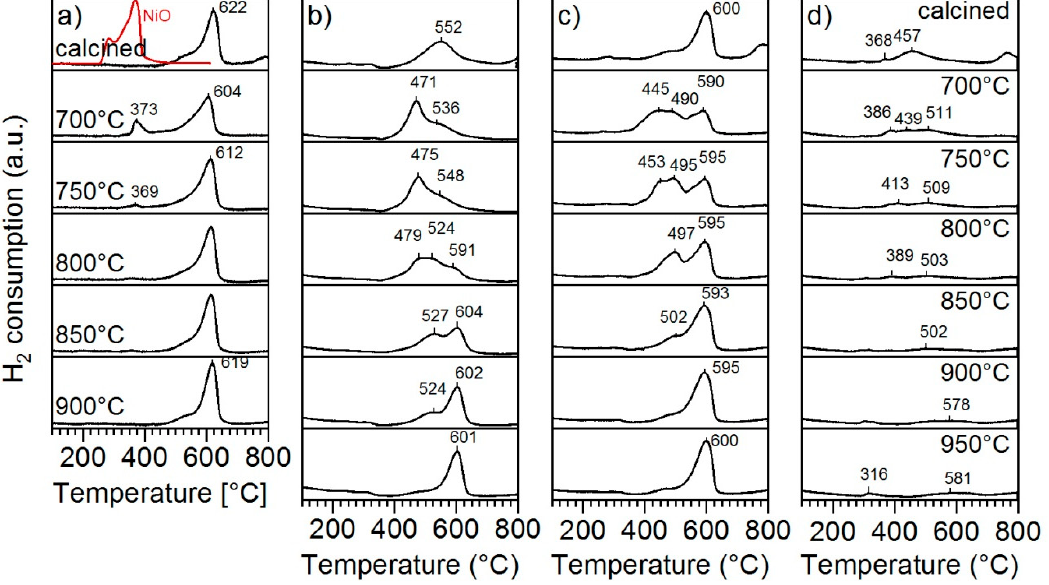
Figure 6. TPR reduction-reoxidation cycles for ( a ) LSTN, ( b ) LSTFN-2Fe5Ni, ( c ) LSTFN-5Fe5Ni and ( d ) LSTF-5Fe. Hydrogen consumption values were normalized by molar quantity of sample. Reoxidized samples were subjected to pre-reduction (10 vol.% H 2 /Ar, 800 ◦ C, 1 h) before reoxidation (20 vol.% O 2 /N 2 , 2 h) at the temperature indicated for each row.